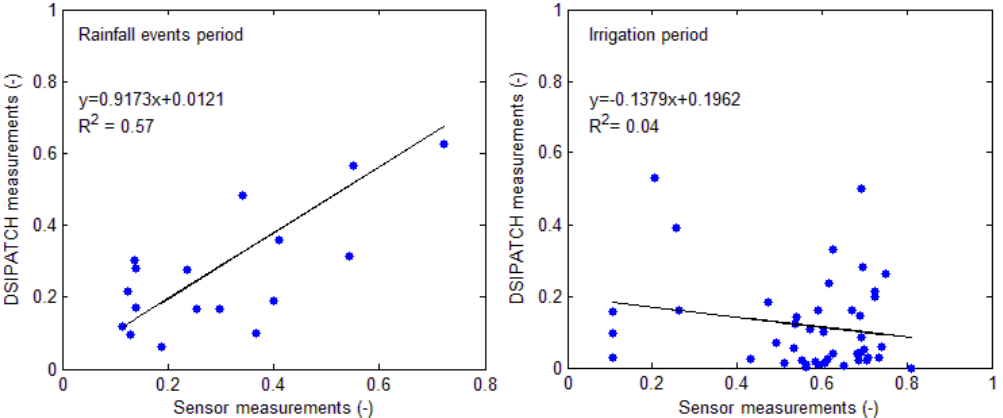
Figure 5. Scatter plot between the average of the normalized soil moisture obtained with EC-5 sensors and the DISPATCH measurements obtained during both hydrologic scenarios, rainfall events and irrigation